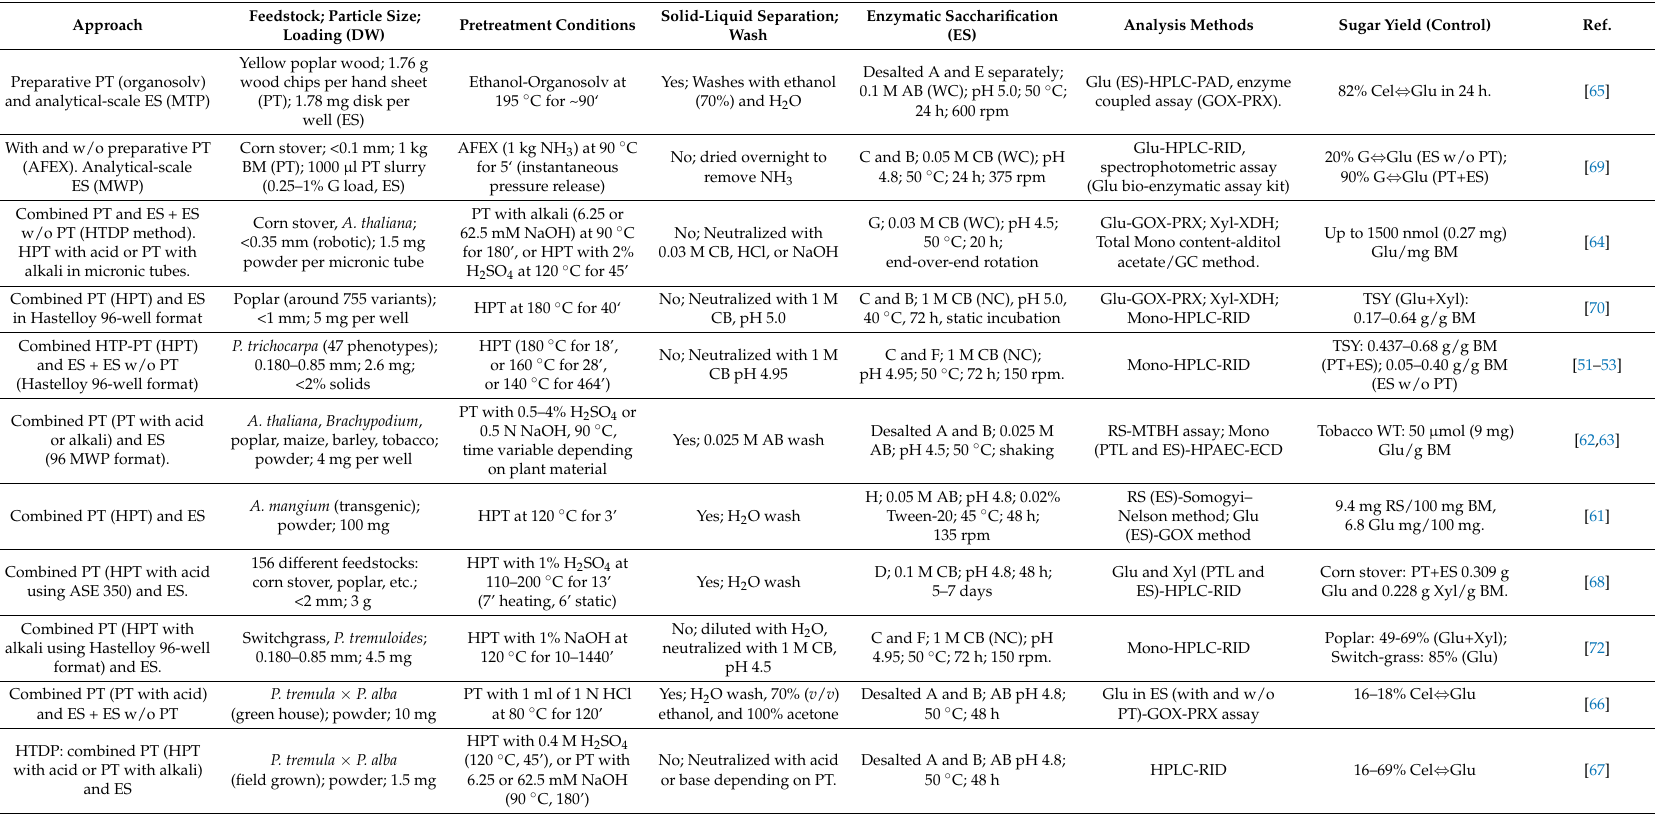
Table 2. Examples of studies involving analytical-scale enzymatic saccharification a,b